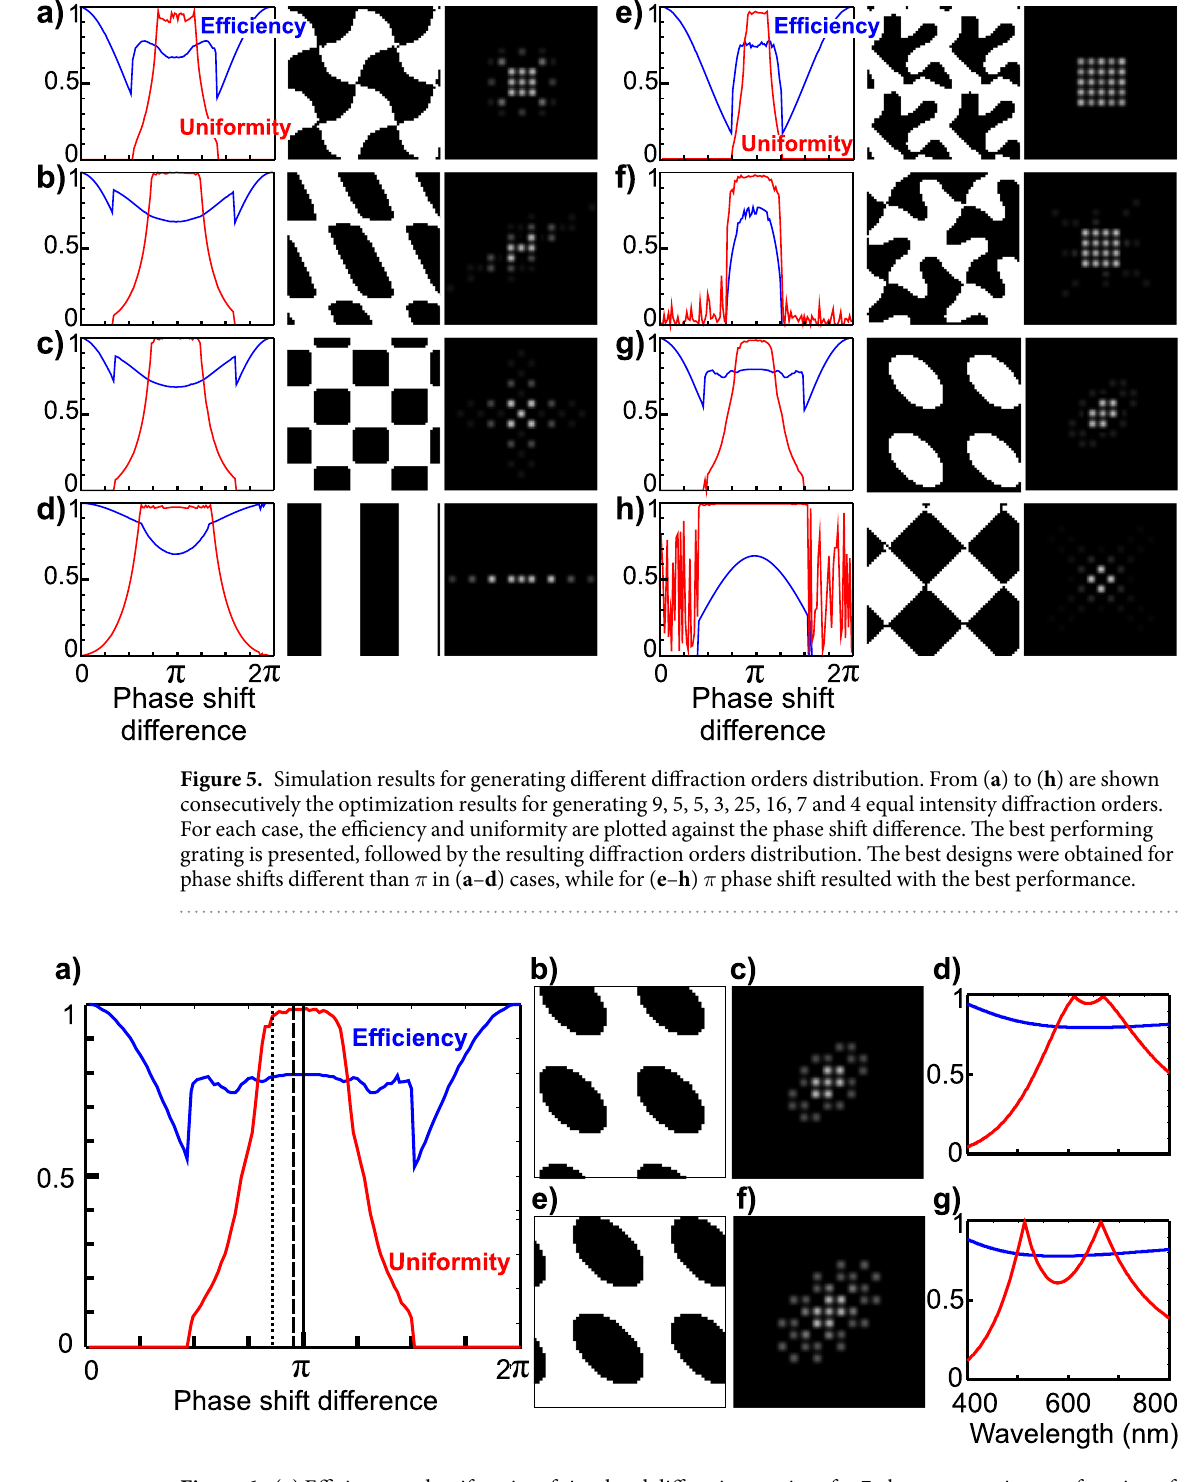
Figure 6. ( a ) Efficiency and uniformity of simulated diffraction gratings for 7 planes generation as a function of the binary step phase-shift. Vertical lines positions: plain: π , dashed: 0.95 × π , dotted: 0.86 × π . ( b ) The physical shape obtained for the 0.95 × π phase shift ( c ) the corresponding diffraction pattern, ( d ) the wavelength dependency of the efficiency and uniformity showing dual bands at 612 nm and 670 nm. ( e ) The physical shape obtained for the 0.86 × π phase shift, ( f ) the corresponding diffraction pattern, ( g ) the wavelength dependency of the efficiency and uniformity showing dual bands at 514 nm and 670